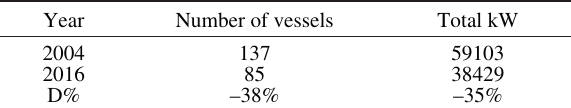
Table 1. – Trends in the fishing capacity of the trawl fleet ≥ 24 m of Mazara del Vallo. Source: MIPAAF data sourced from IREPA (2004 data) and ITAFISHSTAT (2016 data) from the official vessel register.